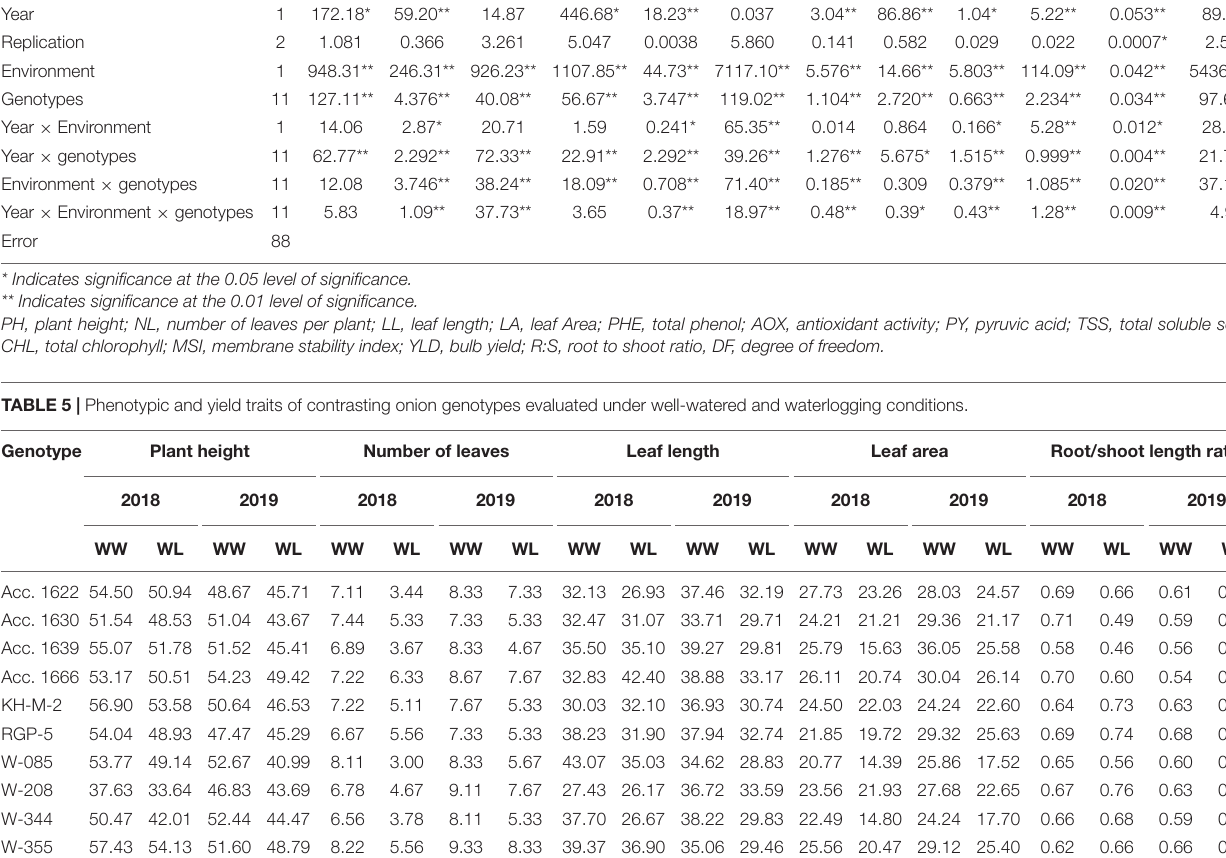
TABLE 4 | Combined ANOVA (mean square) for morphological, physiological, biochemical, and yield traits under well-watered and waterlogging conditions. Source of variation DF PH NL LL LA CHL